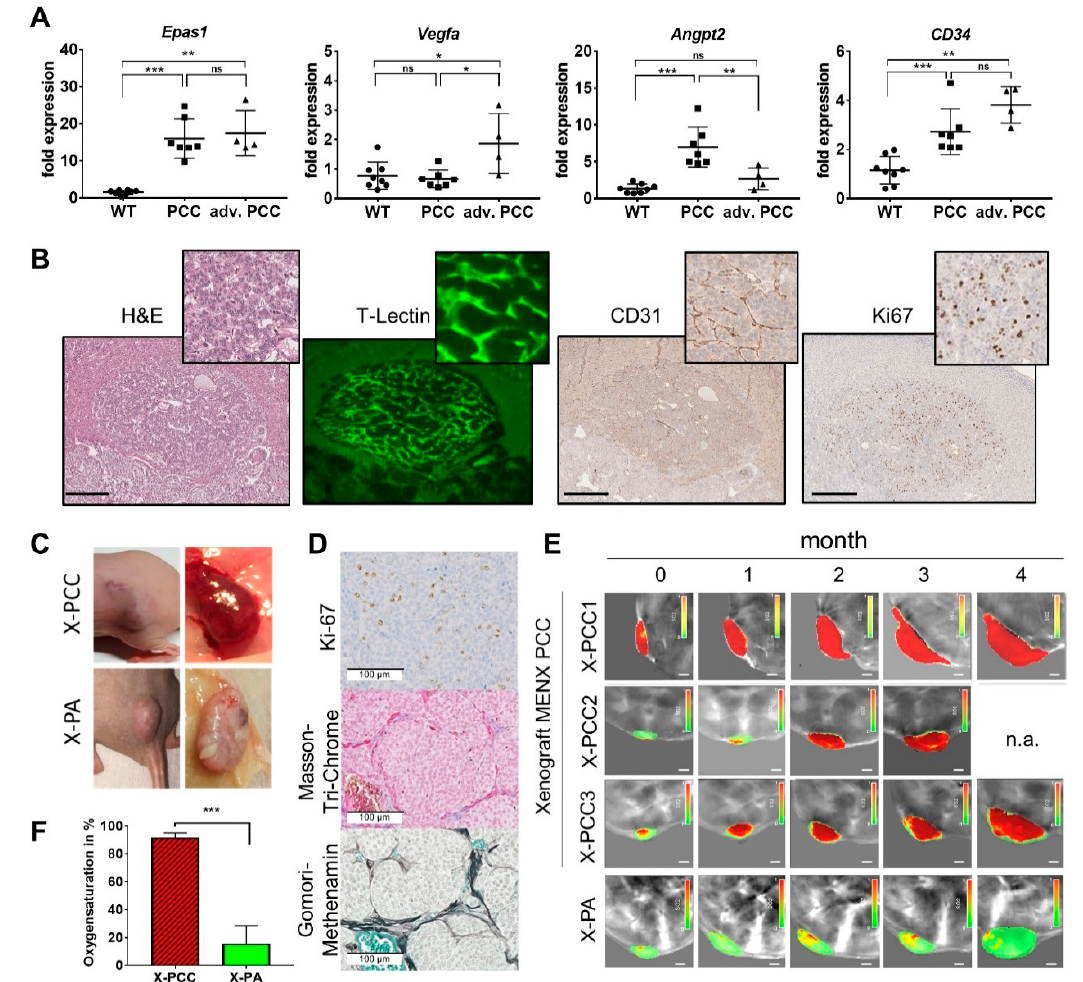
Figure 5. Angiogenesis-related genes and angiogenic features of rat PCCs and of engrafted rat primary PCC cells. ( A ) qRT- PCR-analysis of genes involved in angiogenesis. Depicted is the fold expression relative to a set of four house-keeping genes in WT (n = 8), PCC (n= 7) and an advanced PCC (n = 4) of 7–9-month-old rats. ( B ) Co-registration of 3D microscopy with hematoxylin–eosin (H&E), the IHC staining of a rat PCC nodule and T-Lectin labeling of intact vessels. Shown is an optical section of a 3D stack. Scale bar = 200 µm. ( C ) Xenografts of primary PCC and pituitary adenoma (PA) cells from MENX rats in immunocompromised nude mice. ( D ) IHC analysis of a representative xenografted PCC tissue bar = 100 µm. ( E ) Longitudinal multi-spectral optoacoustic tomography (MSOT) measurements of PCC (X-PCC) and PA (X-PA) xenografts assessing oxygen saturation via oxyHb/(Hb + oxyHb) ratio. The red and green colors indicate the high and low oxygen saturation, respectively. ( F ) Quantitative analysis of the oxygen saturation in tumor xenografts at the 3 months timepoint of the MSOT measurement. Depicted is mean of 3 individual tumors ( A , F ) +/ − SD, p -values were calculated by the Mann–Whitney test. (**** < 0.0001, *** < 0.001, ** < 0.01, * <0.05, ns > =